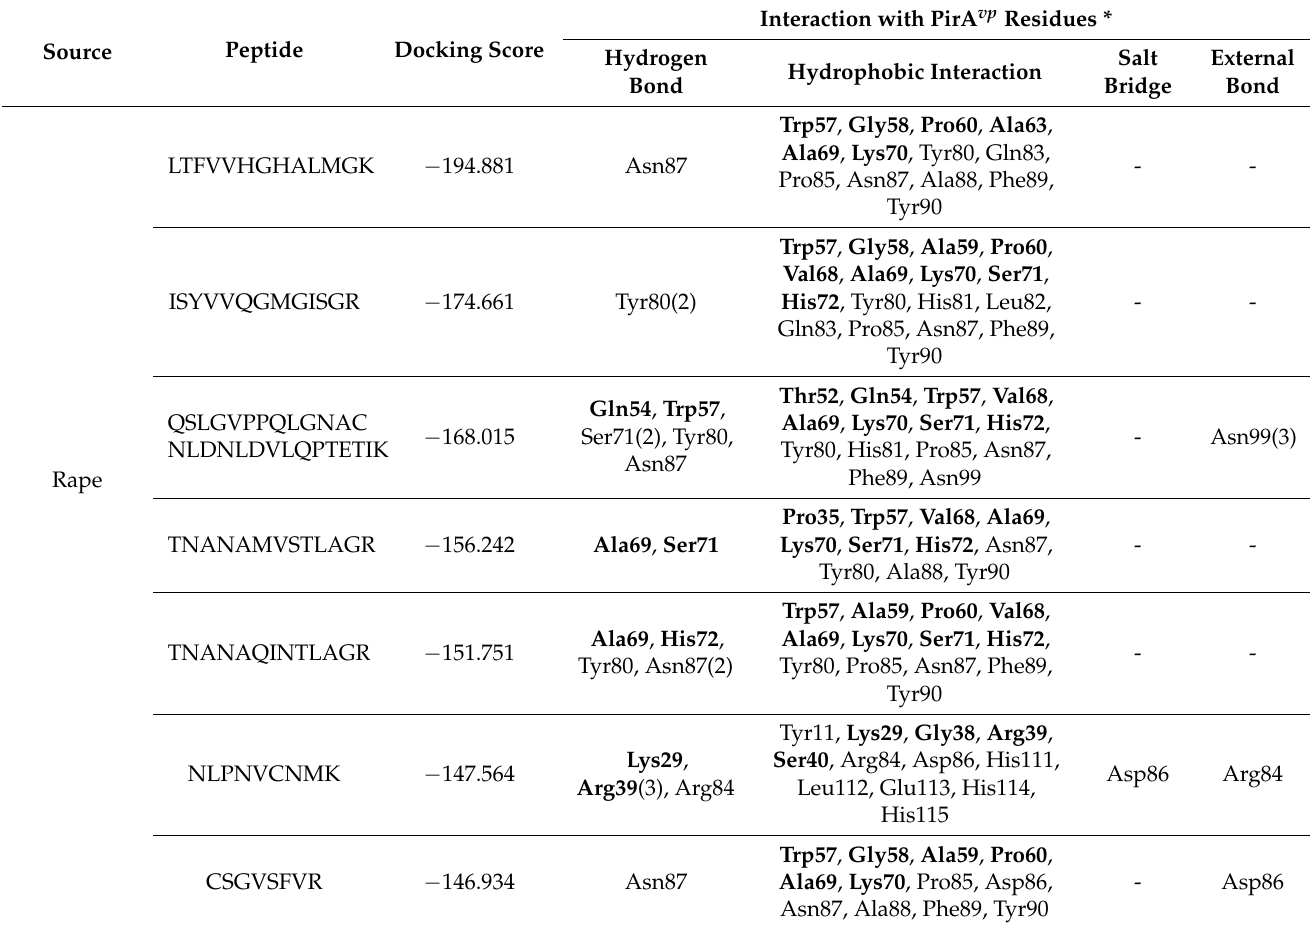
Table 4. Docking scores for interactions between the 18 best-scored oilseed peptides and PirA vp , with details on the PirA vp residues involved in different types of